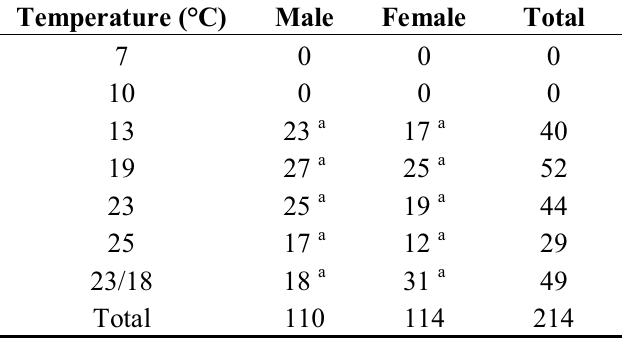
Table 1. Number of male and female adult Tuta absoluta emerging at various temperatures. Different letters within columns denotes significant differences ( p <